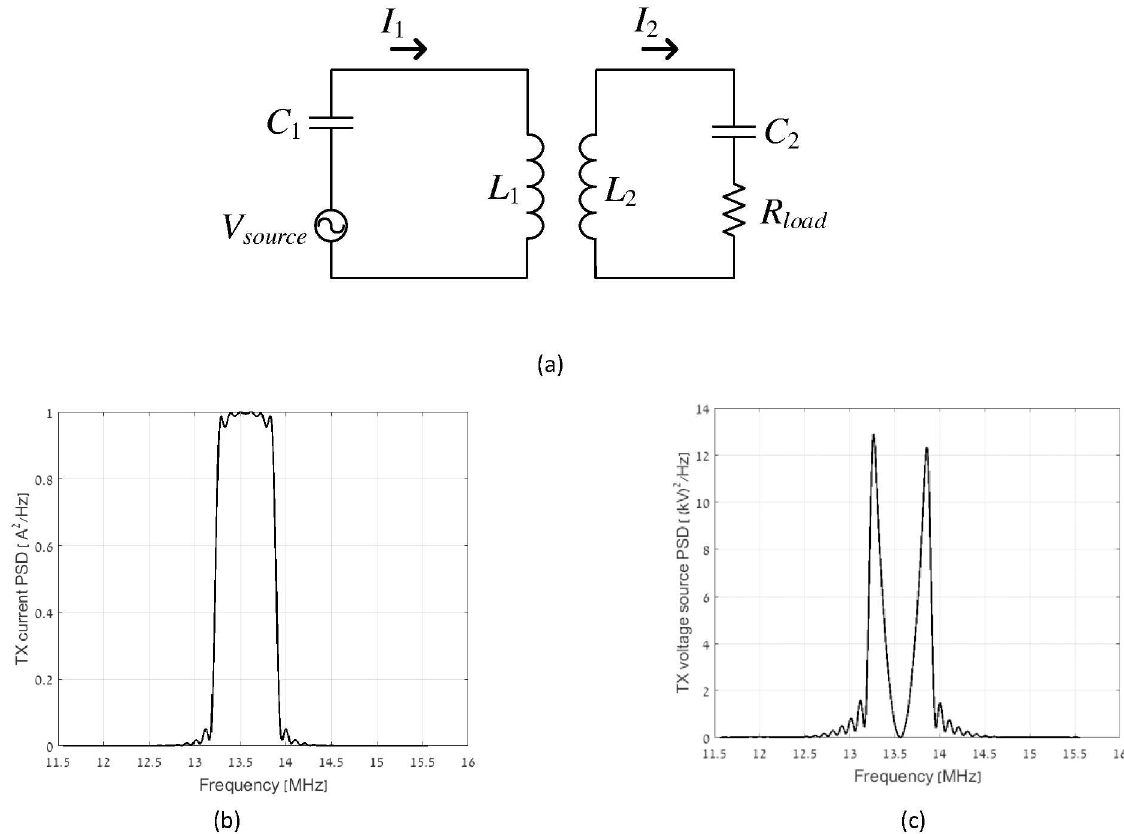
Fig 1. An Example showing the effect of resonance capacitors in broadband magnetic communication. (a) Circuit schematic, (b) Current PSD, and (c) Corresponding voltage PSD resonant communication system.